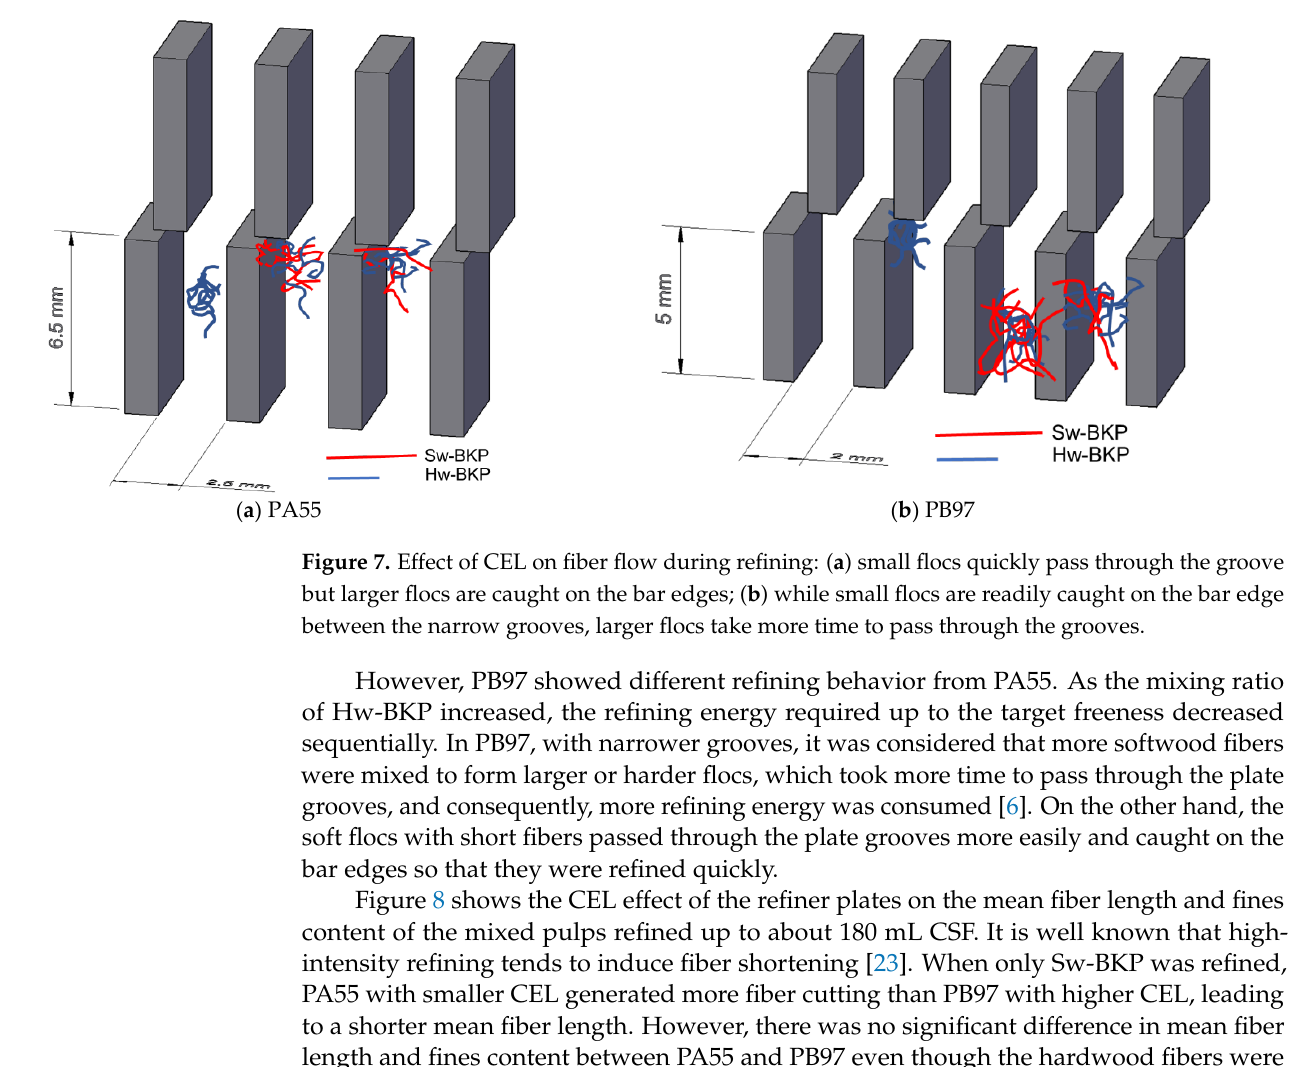
( b ) Figure 6. Effect of CEL on freeness drop of the mixed pulps: ( a ) PA55; ( b ) PB97. When the refining energy consumed up to the target freeness was compared, it was confirmed that the energy consumption of PA55 was significantly reduced, as Hw-BKP was mixed. It is worth noting that the refining energy was remarkably decreased when Hw-BKP was mixed with Sw-BKP compared to Hw-BKP alone. PA55 has a wide groove between the bars, so short hardwood fibers are more likely to pass unrefined. However, as hardwood fibers were mixed with long softwood fibers, the time for the mixed fibers to pass through the grooves was delayed, so it was considered that refining was appro-